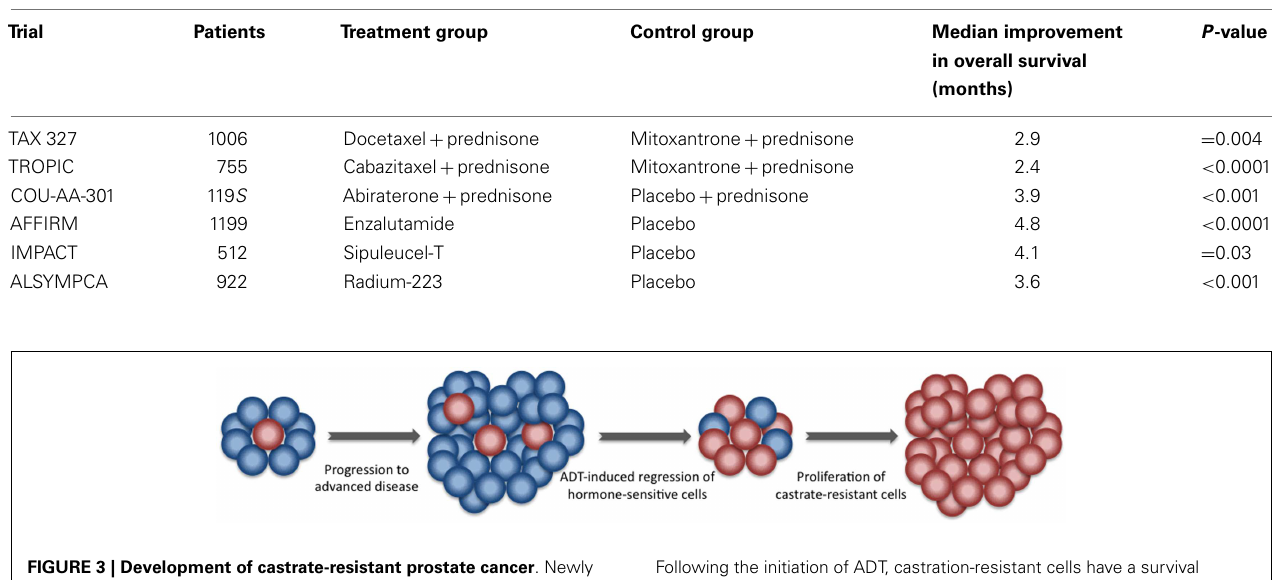
Table 2 | Overall survival benefit of new chemotherapeutic agents for metastatic CRPC .